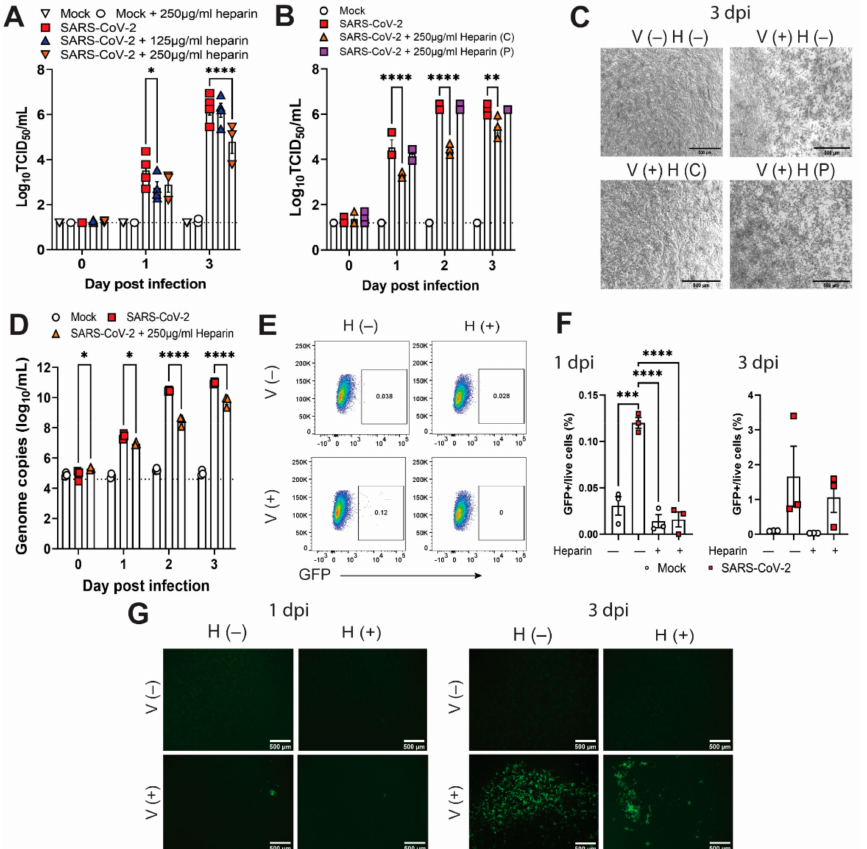
Figure 2. Heparin inhibits SARS-CoV-2 infection in Vero cells. ( A ) Infectious virus titers in super- natants from cells infected with SARS-CoV-2 (MOI 0.0002) and cultured with or without heparin for 3 days. ( B ) Infectious virus titers in supernatants from cells infected with virus incubated with or without heparin for 1 h prior to infection. Cells were cultured either with normal serum-free media (P = pretreatment only) or with continuous heparin (C = continuous) until day 3 post infection. ( C ) Microscopy images of cells at day 3 post infection from B. ( D ) Genome copies (E-gene) in super- natants from cells cultured, with or without heparin, for 3 days. ( E ) Representative flow cytometry plots from cells either mock infected (V − ) or infected with GFP-expressing SARS-CoV-2 virus (V+) and cultured in the presence (H+) or absence (H − ) of heparin. Percentage of GFP-expressing cells by flow cytometry ( F ) and microscopy images of GFP expression ( G ) on day 1 and 3 post infection from E. Data are a representative of 2 replicate experiments except for A that shows the mean titer +/ − SEM of 3 replicates from 4 separate experiments. Scale bar = 500 µ m. Log 10 transformed data were analyzed using Two-Way ANOVA ( A , B , D ) or One-Way ANOVA ( F ) with Dunnett’s multiple comparisons test. *, p < 0.05; **, p < 0.01; ***, p < 0.001 and ****, p <